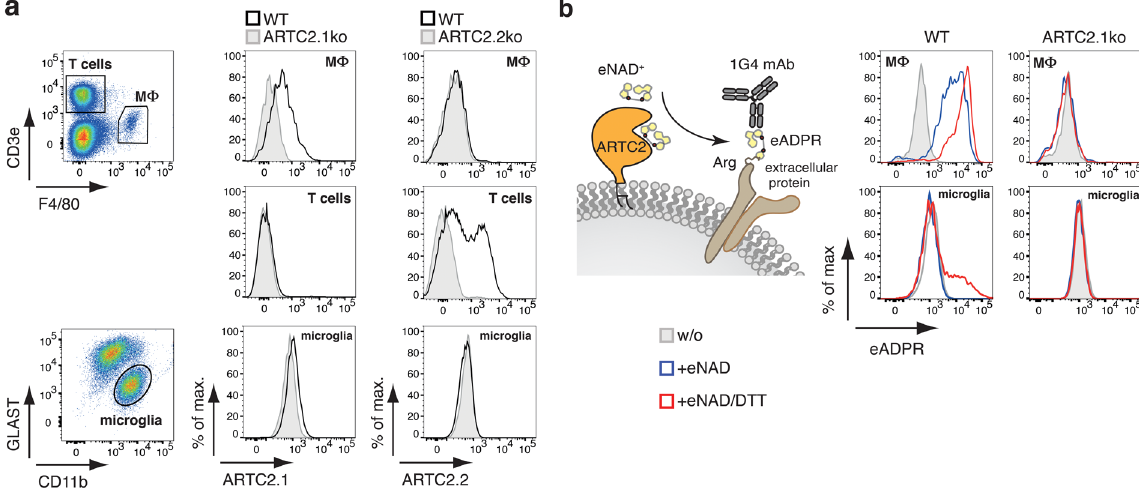
Figure 1. Ecto-ART expression and activity on microglia from mixed glial cell cultures. ( a ) Reactivity of fluorochrome-conjugated ARTC2.1 and ARTC2.2-specific mAbs was analyzed by flow cytometry of BALB/c WT spleen CD3 + T cells, F4/80 + macrophages (M Φ ). or CD11b + GLAST − microglia from BALB/c WT mixed glial cell cultures. BALB/c ARTC2.1 − / − and ARTC2.2 − / − cells were used as negative controls. ( b ) Etheno- NAD (eNAD + ) can be used as surrogate substrate for ARTC2, which etheno-ADP-ribosylates cell surface proteins. This can be detected by use of etheno-adenosine-specific mAb 1G4. Ecto-ART activity was analyzed by measuring etheno-ADP-ribosylation of cell surface proteins on BALB/c WT and ARTC2.1 − / − spleen M Φ (upper panel) and on microglia from mixed glial cell cultures (lower panel) after incubating cells with 100 µ M eNAD + (blue), with 100 µ M eNAD + and 2 mM DTT (red) or without additions (grey). Etheno-ADP-ribosylated proteins were detected with mAb 1G4. Data are representative of 3 independent